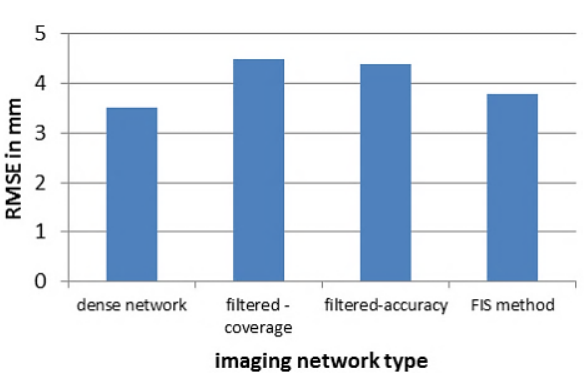
Figure 16. RMSE of the